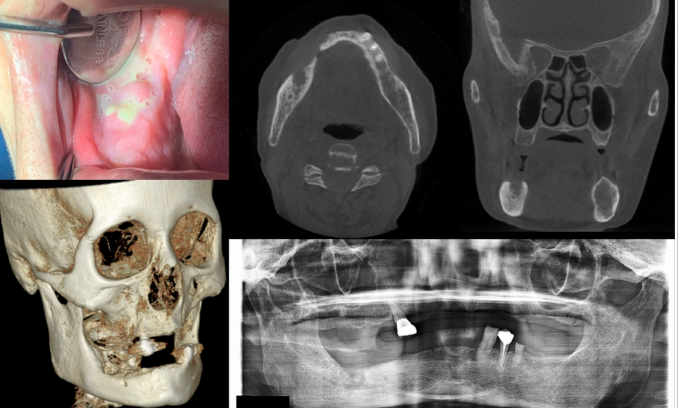
Figure 3. Case 3 with MRONJ Stage 2: Clinical photo, panoramic view, and computed tomogra- phy imaging including three-dimensional reconstruction showing exposed alveolar bone with pus discharge on the right mandibular posterior area. A 68-year-old female patient with a history of intra- venous administration of ibandronate for eight years and intravenous administration of denosumab for the last year complained of facial swelling, severe pain, and pus discharge. She had undergone extraction of the right lower second molar at the private dental clinic to relieve the facial swelling and pain. Symptoms were relieved slightly after extraction but worsened again after two weeks. As a result of the examination, exposed bone and infection signs were